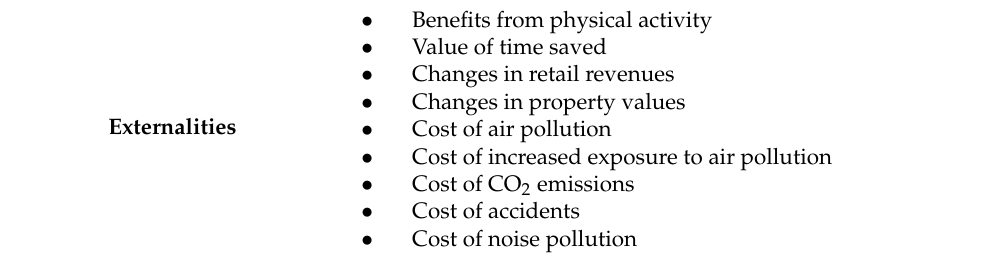
Table 3. Externalities considered in the SAVi assessment for PBS in Dwarka